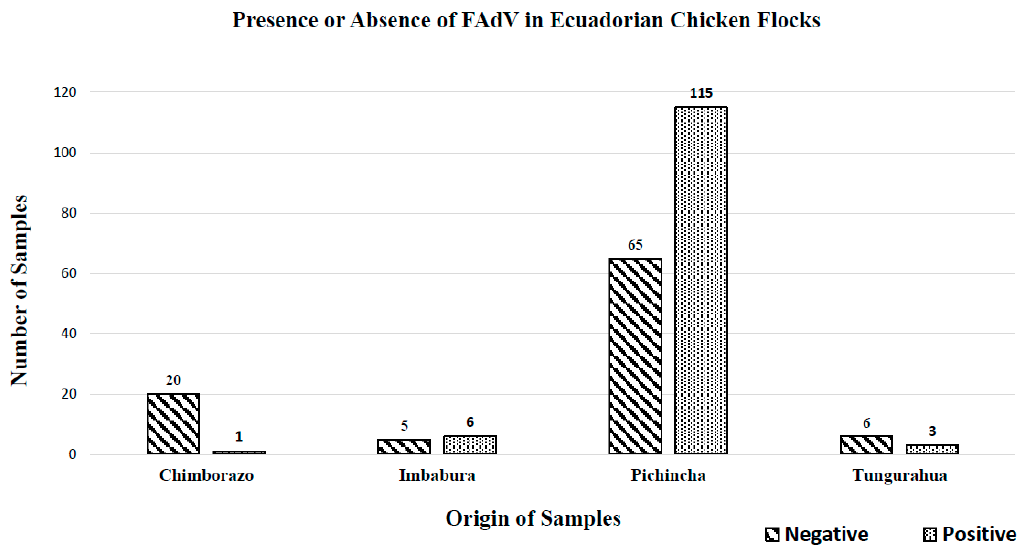
Figure 1. Presence or absence of FAdV in Ecuadorian chicken flocks and virus distributions in the provinces of Ecuador. The virus was detected in BC (91.2%), LH (9%), and BH (2%), with BC having a greater number of positive samples. FAdV was detected from 7 to 42 days of age in BC, in BH at 4 days of age, and LH from 14 to 45 weeks of age (Table 2). Table 2. Molecular detection and quantification of FAdV in Ecuadorian chicken flocks.